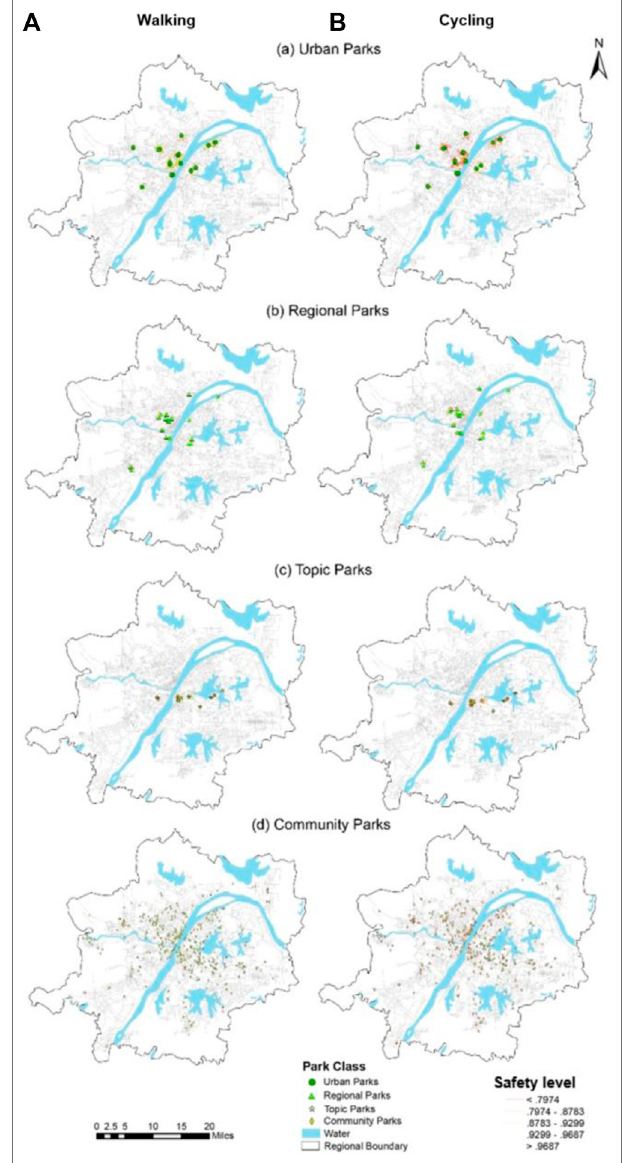
FIGURE 8 | Spatial disparity ATTS in the PGS